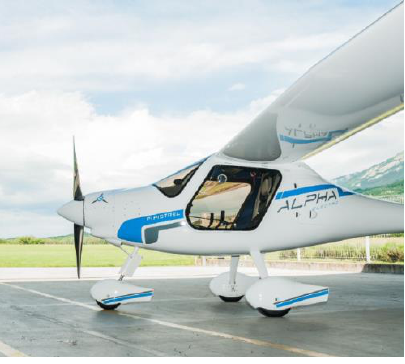
Fig. 1. Ultralight aircraft Alpha Electro